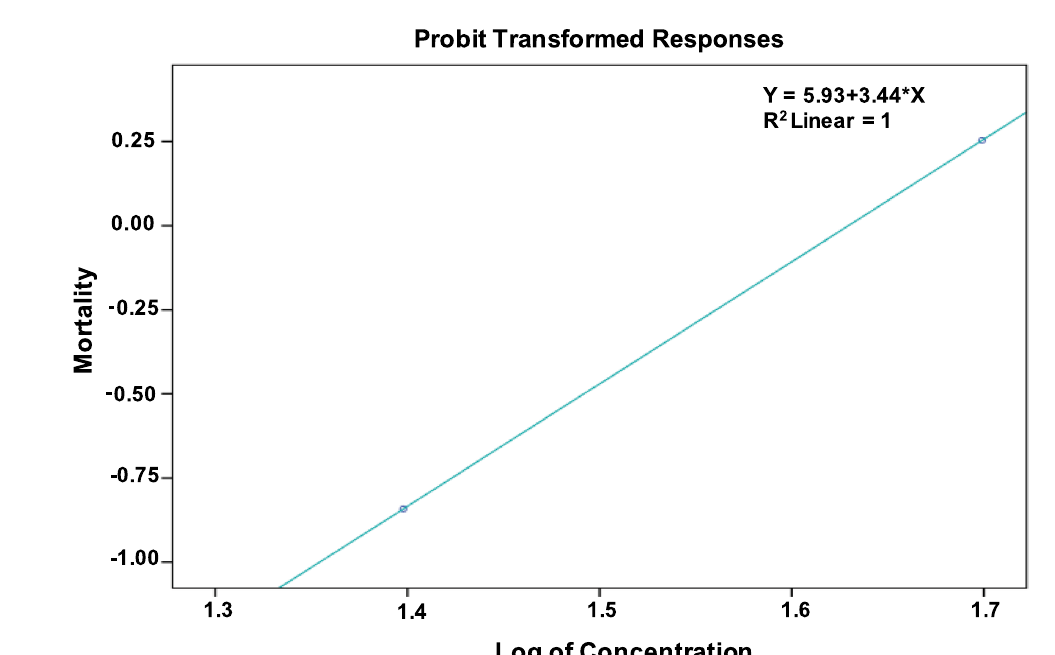
Fig. 1 Concentrations‑mortality relationship (probit transformed responses) of RIPEX 48% EC against B. alexandrina snails after 1 day of